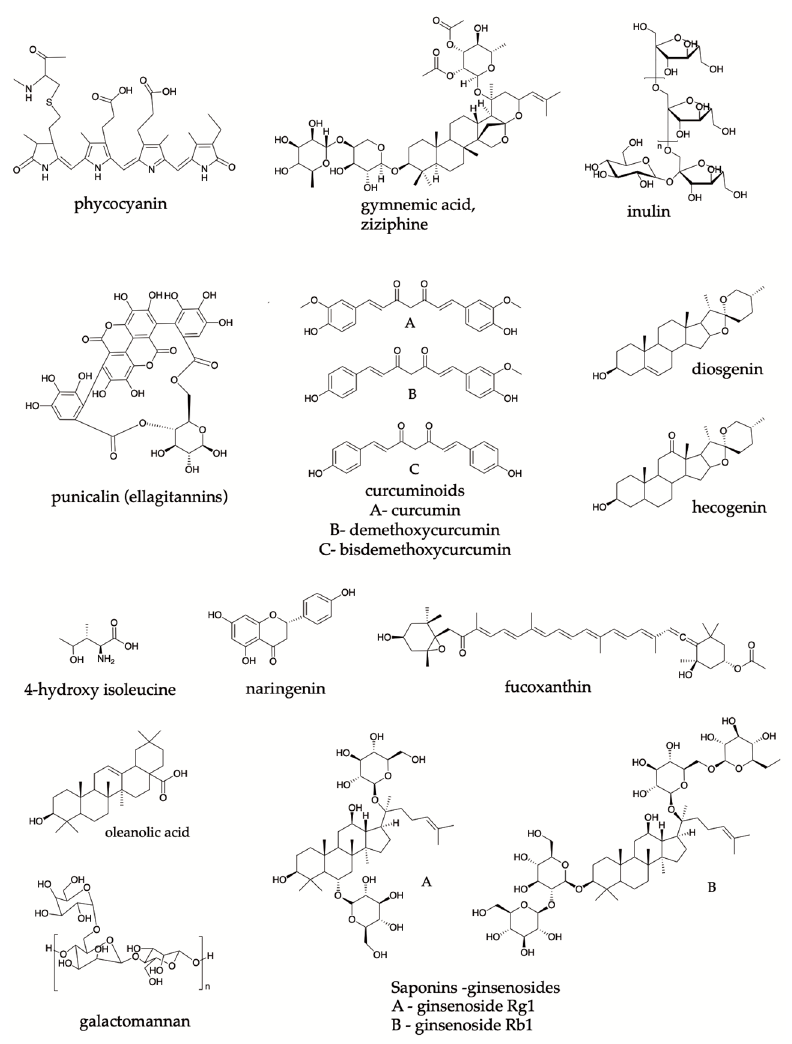
Figure 5. Principal metabolites reported by patents from natural products.